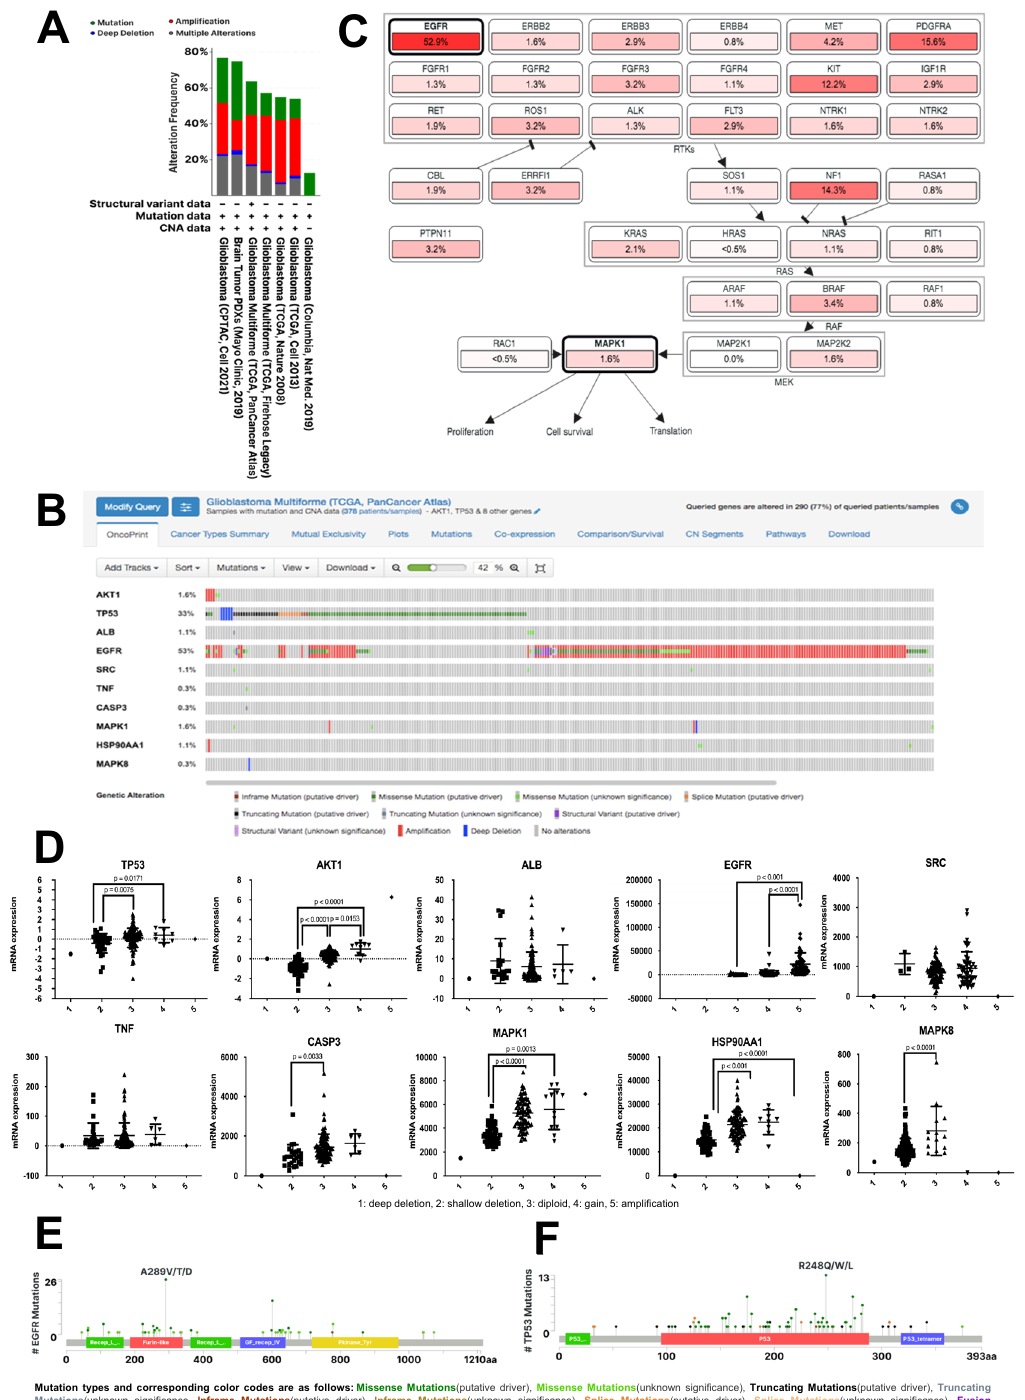
Figure 4. ( A ) Summary of alterations in 10 PTCG reported in GBM studies using cBioportal. (B) OncoPrint analysis of 10 PTCGs in patients with GBM from TCGA PanCancer Atlas study, as analyzed using cBioportal. ( C ) Pathway enrichment analysis related to genetic alterations in 10 PTCGs in patients with GBM from TCGA PanCancer Atlas, as analyzed using cBioportal. ( D ) Copy number alterations of 10 PTCGs in patients with GBM from TCGA PanCancer Atlas, as analyzed using cBioportal. Statistical analysis was performed using one-way ANOVA with Tukey’s multiple comparison test. Mutation profiles of ( E ) EGFR and ( F ) TP53 in patients with GBM from TCGA PanCancer Atlas, as analyzed using